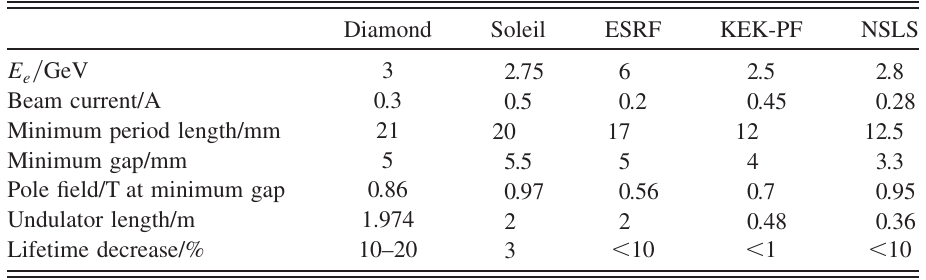
TABLE II. Minimum period length and gap of in-vacuum undulators in light-source